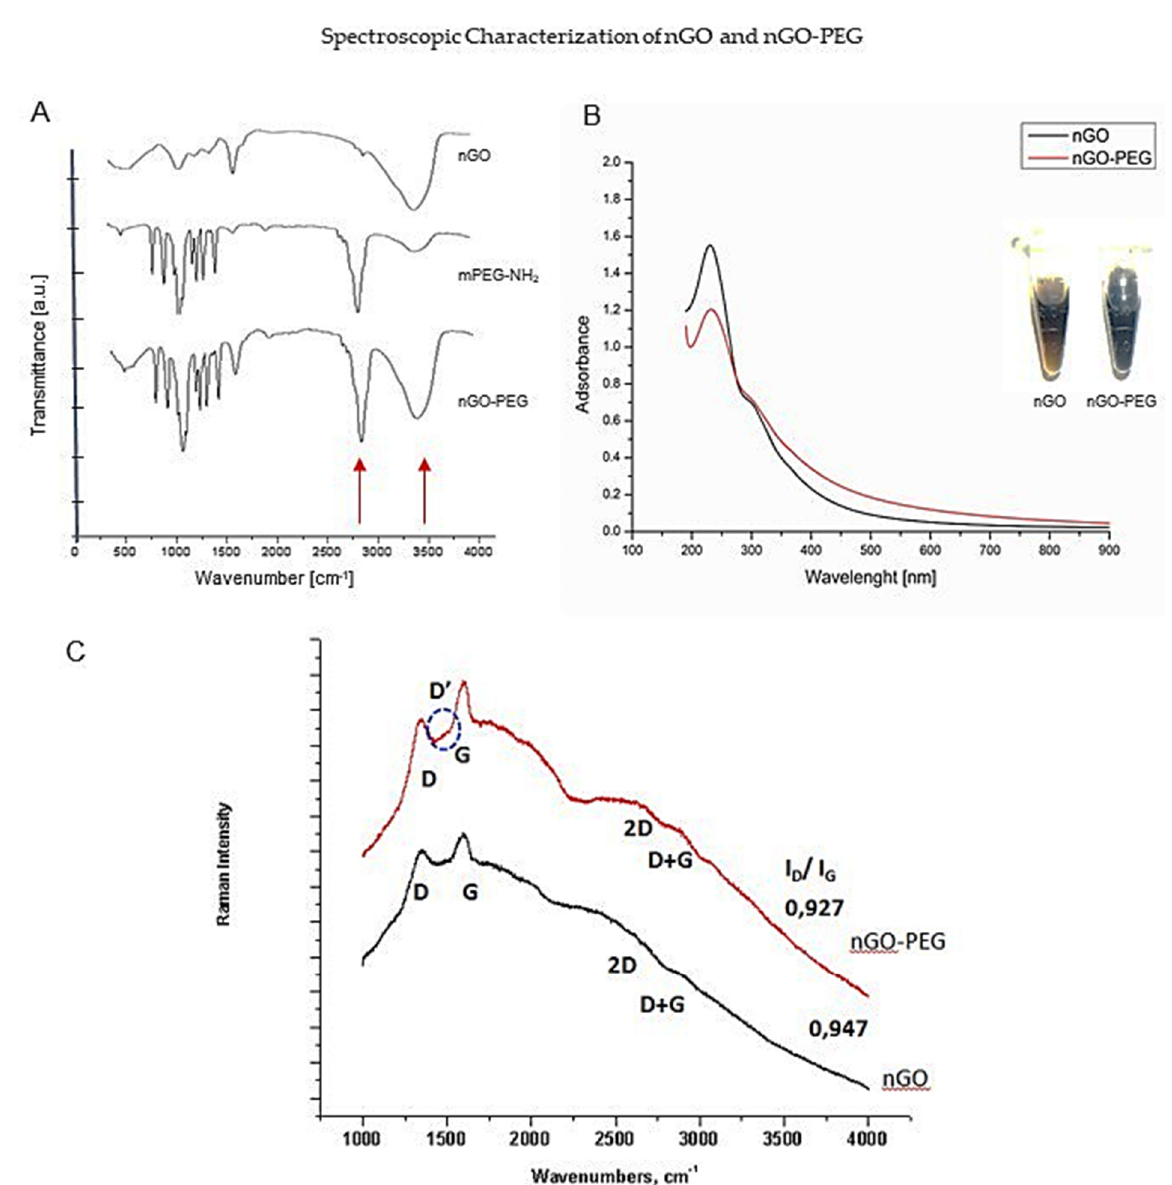
Figure 1. Spectroscopic characterization of nGO and PEGylated nGO (nGO-PEG). ( A ): Fourier Transform Infrared (FTIR) Spectroscopy of nGO and nGO-PEG nanoparticles: Infrared spectra of nGO and nGO-PEG dehydrated samples were recorded using a Thermo Nicolet 6700 spectrometer (Thermo Fisher Scientific, USA) in the mid-infrared region (4000–400 cm − 1 ) at a resolution of 2 cm − 1 . The FTIR spectra of Ngo PEG show the proof for the PEGylation modification (red arrows). ( B ): Ultraviolet (UV)-Visible Spectroscopy: UV-VIS-absorption spectra were acquired using a Specord 210 Plus (Edition 2010, Analytik Jena AG, Germany) spectrophotometer. Spectra were recorded in the range of 190–1100 nm. ( C ): Raman spectra of nGO and nGO-PEG with assignment of the important peaks: LabRAM HR Visible Raman spectrometer was used and excitation was performed with 633 nm He-Ne laser.